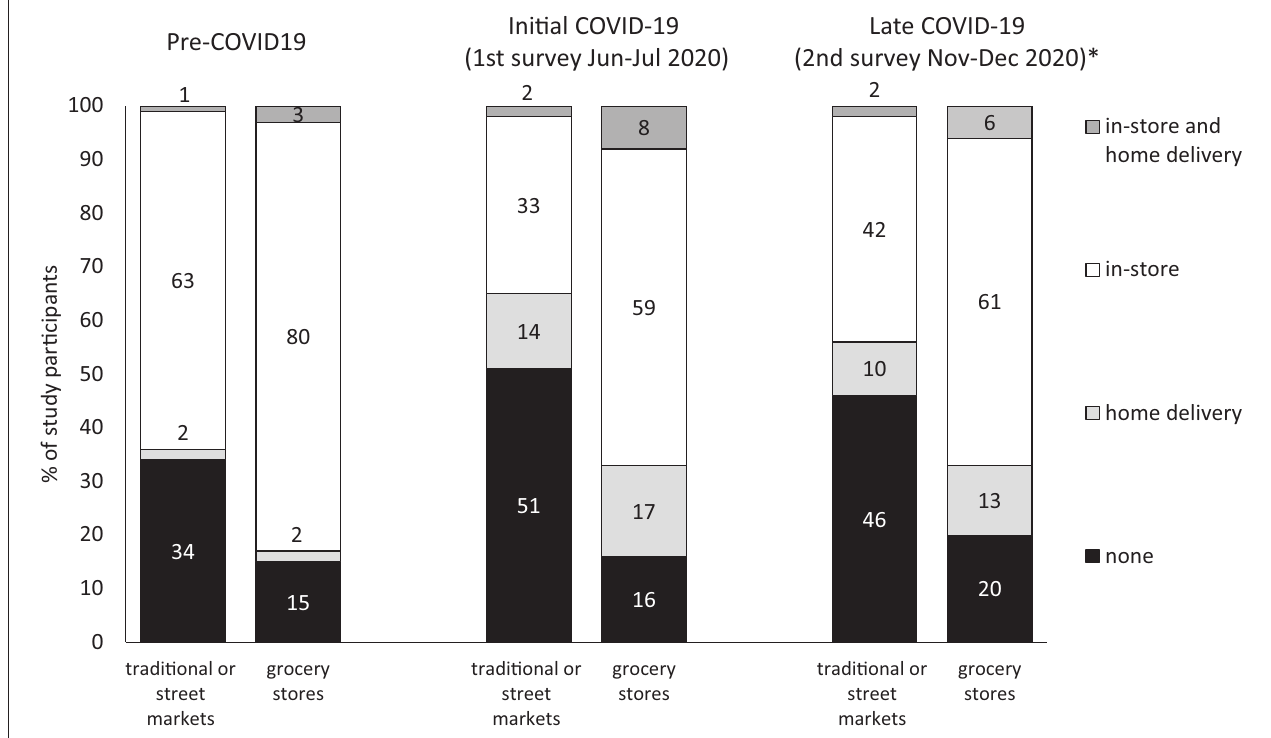
FIGURE 2 | Food shopping place and modality pre-COVID 19 and during initial and later stages of COVID-19 pandemic (1st and 2nd survey round). *Weighted to maintain the distribution of sociodemographic variables of 1st round’s participants.